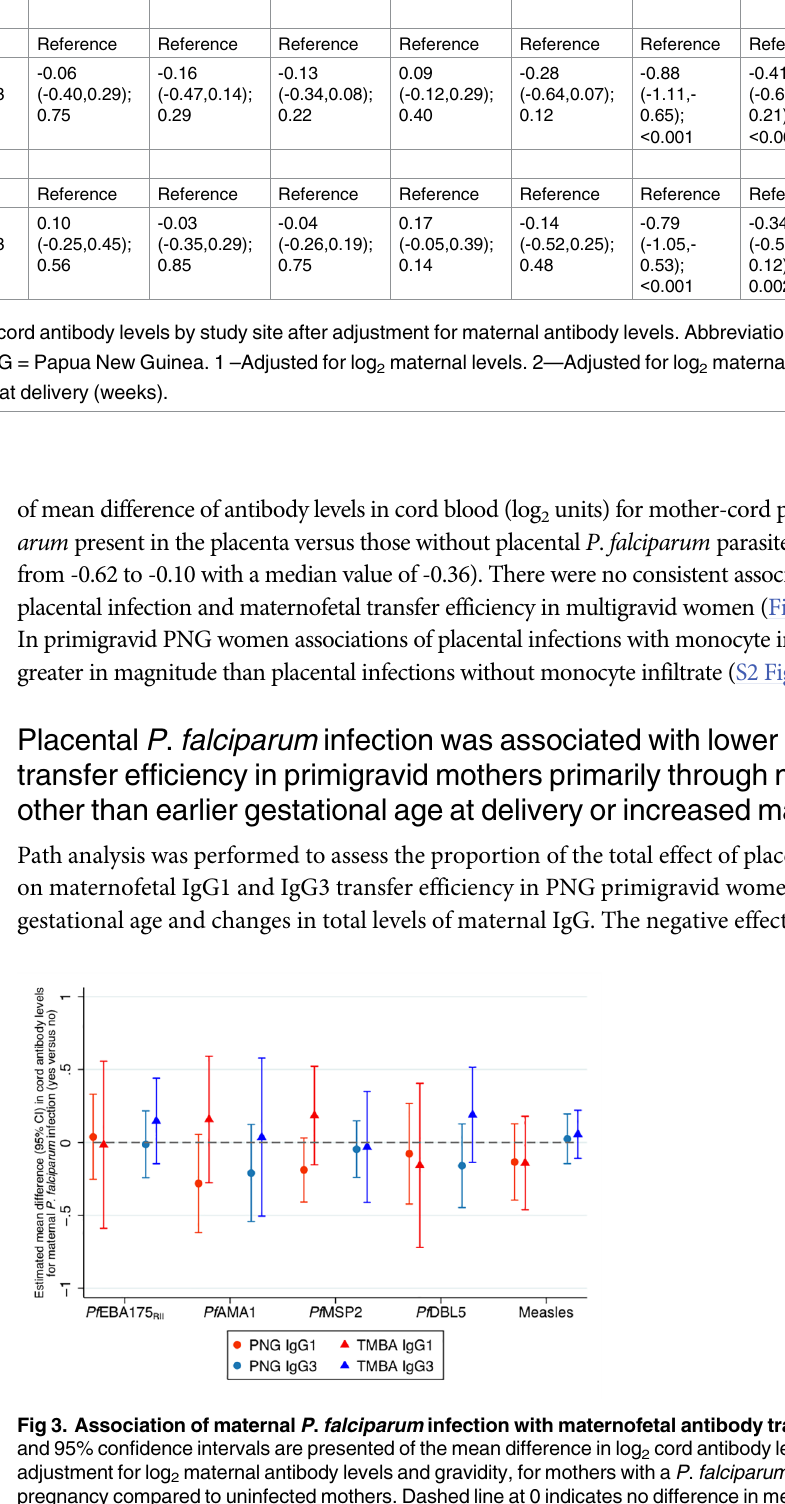
Table 2. Association of study site with maternofetal antibody transfer efficiency; estimated adjusted mean difference (95% confidence intervals) and p-values are presented.